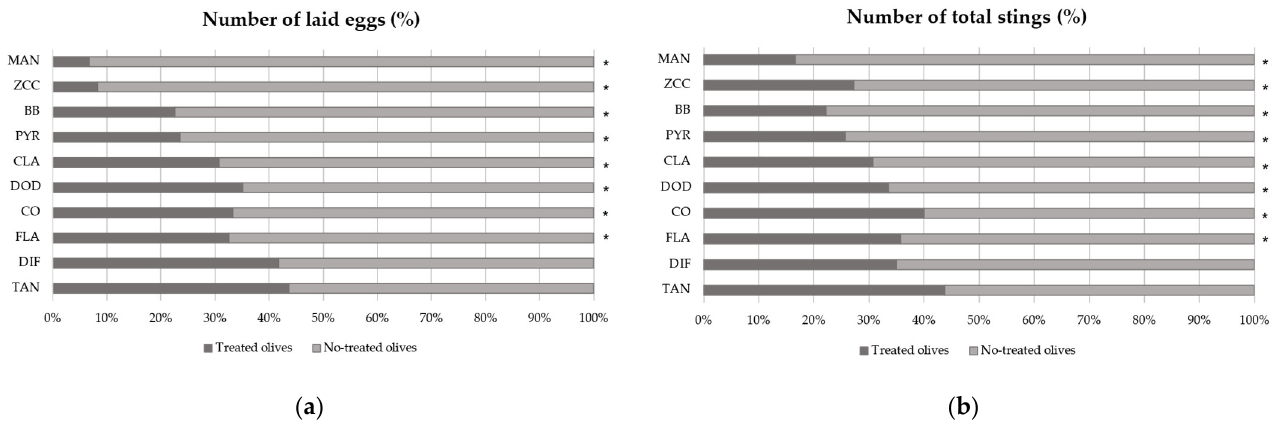
Figure 2. Effects of treatments on the preference for oviposition of B. oleae evaluated by counting ( a ) number of laid eggs (%) and ( b ) number of total stings (sterile stings plus stings with laid eggs) in treated and untreated olives. MAN: mancozeb, ZCC: zinc-copper-citric acid biocomplex, BB: B. bassiana , PYR: pyraclostrobin, CLA: clay, DOD: dodine, CO: copper oxychloride, FLA: flavonoids, DIF: difeconazole, TAN: tannins. The results are the summed values of thirty replicates in independent repeats. * p < 0.05, significant differences compared to the control (paired samples Wilcoxon test).